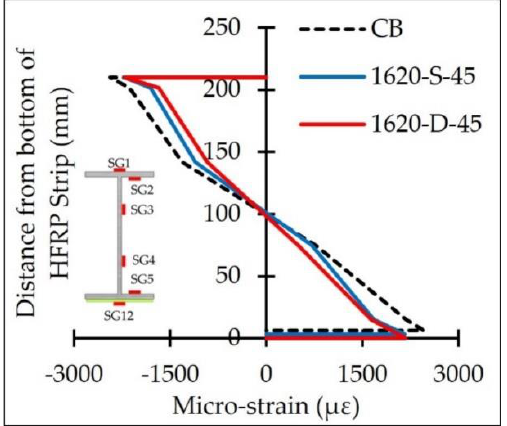
Figure 27. Strain profiles at the mid-segments of 1620-S-45 and 1620-D-45 at 310 kN.